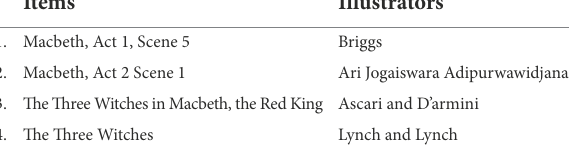
TABLE 2 List of competed graphics at the Graphic Shakespeare Competition.